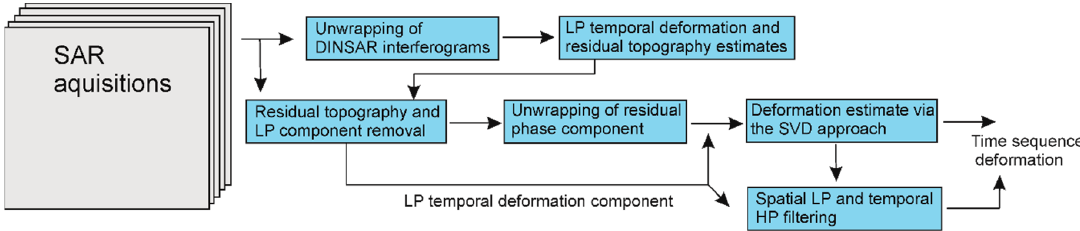
Figure 3. Small BAseline Subset (SBAS) workflow.